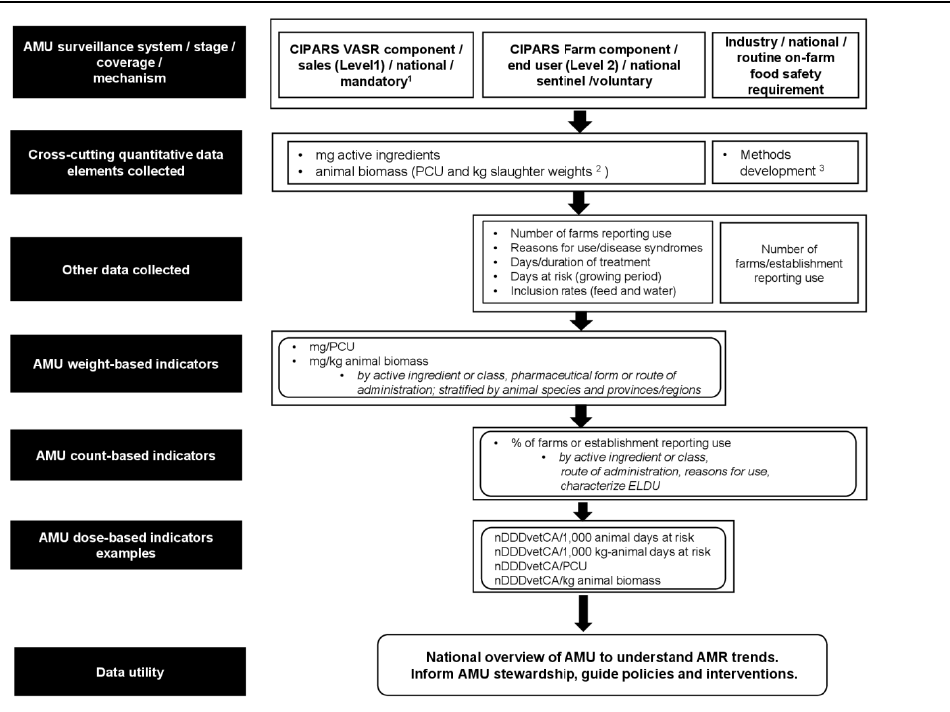
Figure 4. Application of the MDS-AMU-surv in Canadian animal sector. 1 In addition to VASR, CIPARS access open data collected by Fisheries and Oceans Canada under the Aquaculture Activities Regulations of the Fisheries Act. 2 Aquaculture data are not yet reported by biomass unit (i.e., using the AMU indicators routinely used by CIPARS for AMU reporting in terrestrial animals), but exploration of methodological options for data analysis and future reporting are underway [31]. 3 At the time of writing, the industry (i.e., poultry sector) utilizes count-based indicators to communicate results within their producer networks; as mentioned above, methodology for quantitative AMU indicator analysis and reporting are underway. AMU — antimicrobial use. ELDU — extra-label (off-label) drug use. nDDDvetCA — number of defined daily doses in animals using Canadian standards. PCU — population correction unit. VASR — Veterinary Antimicrobial Sales Reporting system; the data collection platform for national sales data. Levels 1 and 2 pertain to the stage of data collection indicated in Figure 1. 3. Discussion The development of the MDS-AMU-surv in the Canadian food animal sector demonstrates that different sectors can work together under a voluntary platform. Multisectoral collaboration such as this is useful in addressing components of the Pan- Canadian Framework for action on AMU/AMR in the absence of a formal multisectoral One Health governance mechanism [32]. The authors acknowledge that the working group discussions on MDS-AMU-surv predate the regulatory shifts in AMU; this paper is reflective of the changes including the mandatory reporting requirements to the manufacturers, importers, and compounders, refinements in CIPARS surveillance methodology, and reporting (i.e., metrics and indicators), additional AMU data now